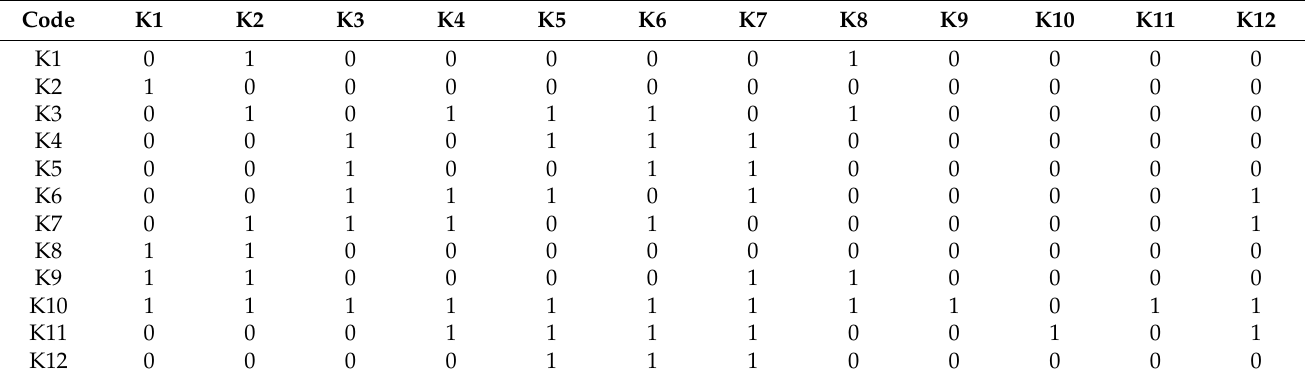
Table 7. The adjacency matrix of key hindering factors of BIM applications.